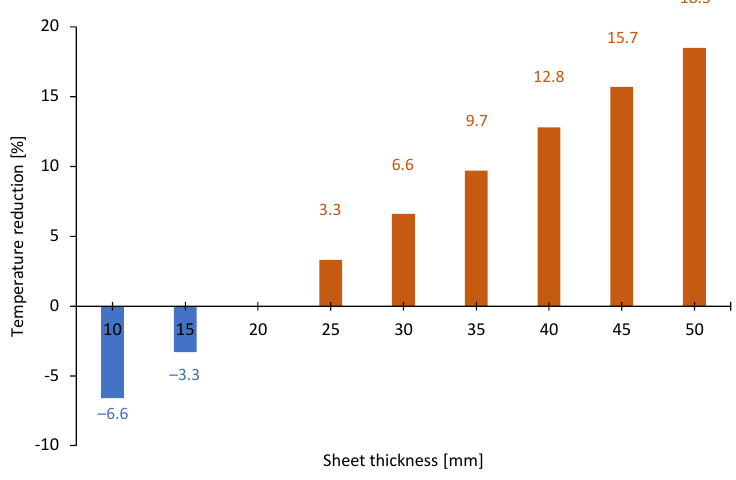
Figure 6. Comparison between the temperature of the flue gas measured during the experiment, the regression curve, and the numerical output.